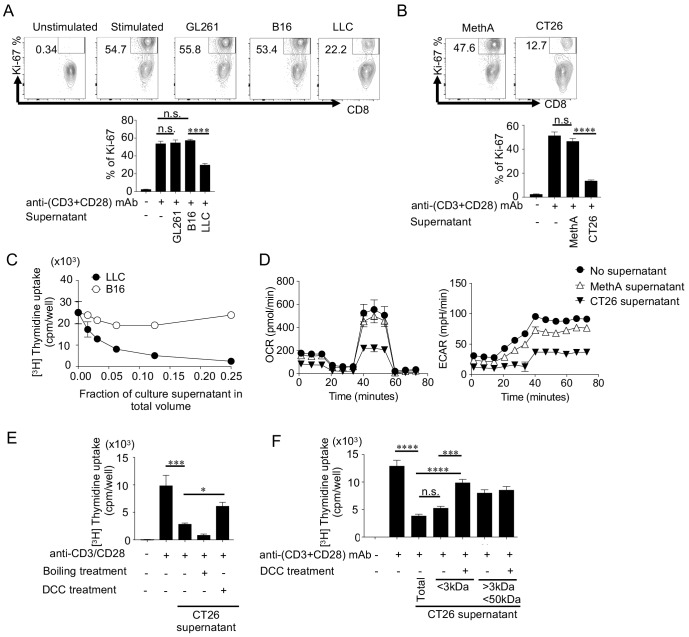
Tumor-derived suppressive factor inhibits proliferation and mitochondrial function of CD8+ T cells in vitro.As per schedule mentioned in Figure 6A, naïve CD8+ T cells were stimulated in the presence of culture supernatant. (A-B) Naïve CD8+ T cells were stimulated in the presence of culture supernatant of tumor cells from C57BL/6N (A) or BALB/c (B) background. Ki-67 expression was analyzed intracellularly by flow cytometry. Representative FACS profile (upper panel) and frequency of CD8+ KI-67+ T cells (lower panel) are shown. Control groups are shared between A and B. (C) Naïve CD8+ T cells were stimulated in the presence of serially diluted culture supernatants from B16 and LLC. T cell proliferation was measured by 3 H-thymidine incorporation assay. (D) OCR (left) and ECAR (right) were measured of naïve CD8 + T cells that were stimulated in the presence of culture supernatant from MethA and CT26. (E) CT26 supernatant was heat-inactivated to denature protein components. To remove small molecules, supernatant was treated with DCC. The effect of treated supernatant on naïve CD8+ T cell proliferation was assessed. (F) Using different cut-off filters, CT26 supernatant was fractionated into <3kDa and <50kDa fraction that were further treated with DCC. The effect of treated fractions on naïve CD8+ T cell proliferation was assessed. Data represent the means ± SEM of triplicate wells. *p < 0.05, ***p < 0.001, ****p < 0.0001, one-way ANOVA analysis. Data are representative of three independent experiments. n.s. represents ‘not significant’.